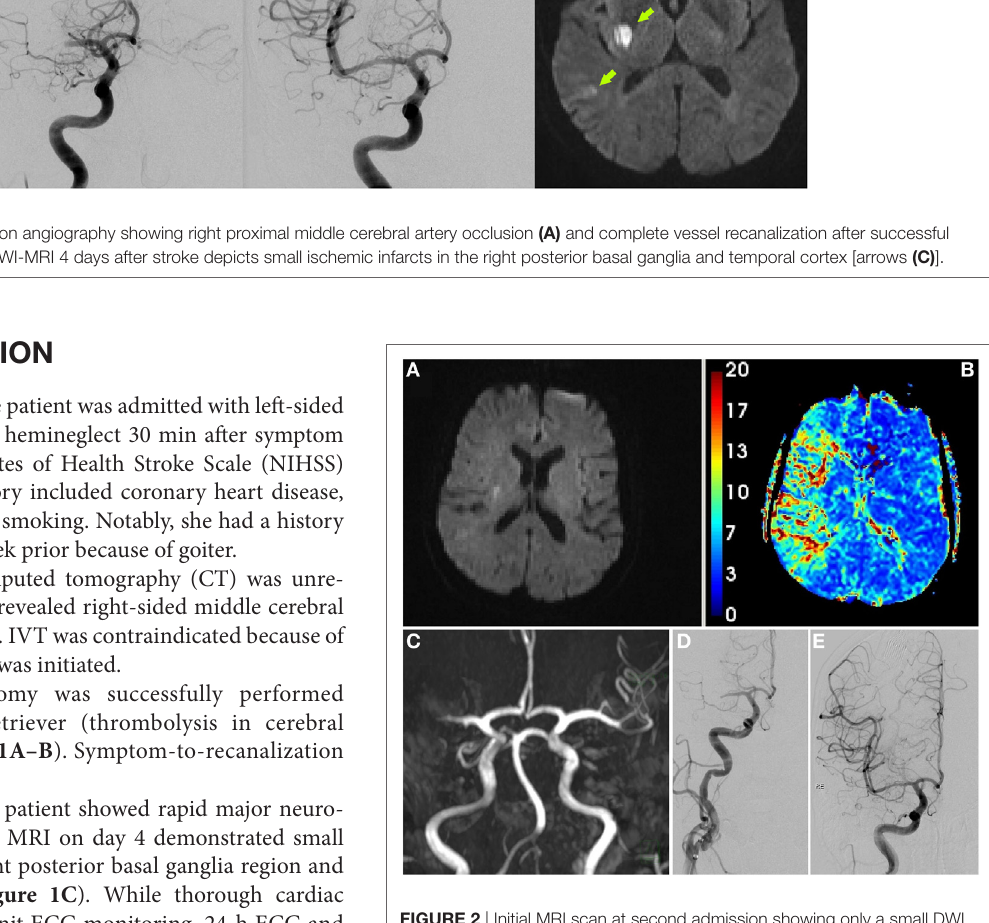
FiGURe 2 | Initial MRI scan at second admission showing only a small DWI lesion corresponding to the preceding stroke (a) , hypoperfusion of large parts of the middle cerebral artery (MCA) territory [ (B) , mean transit time], and right proximal MCA occlusion [ (C) , time-of-flight angiography]. Digital subtraction angiography pre- (D) and post-thrombectomy (e) .